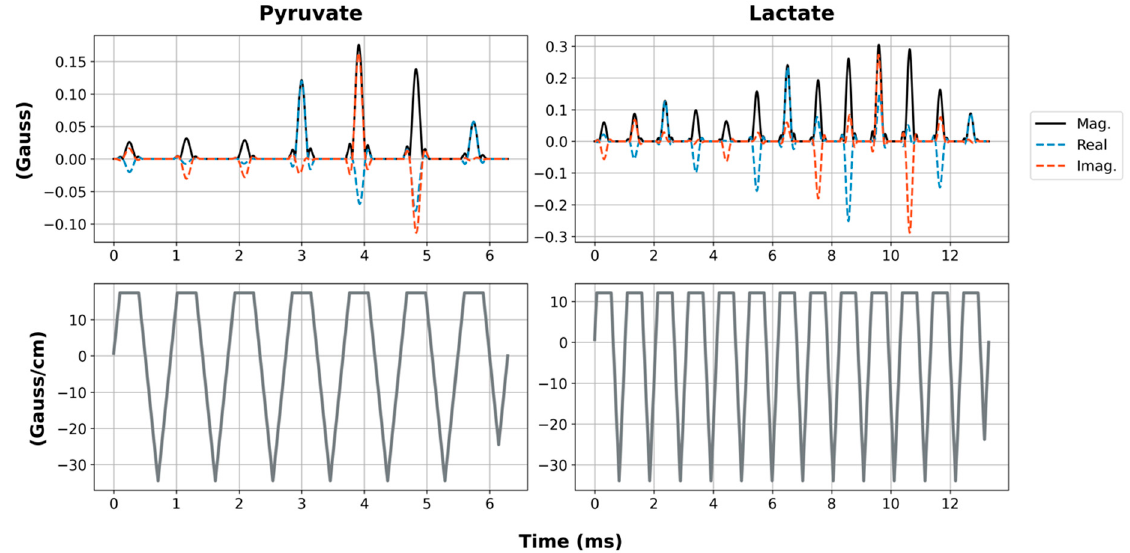
Figure 2. RF pulse waveforms for pyruvate and lactate SSRF pulses ( top row). The solid black lines are the pulse magnitude, while the dashed blue and red lines are the real and imaginary components, respectively. The gradient waveforms are shown on the bottom row.